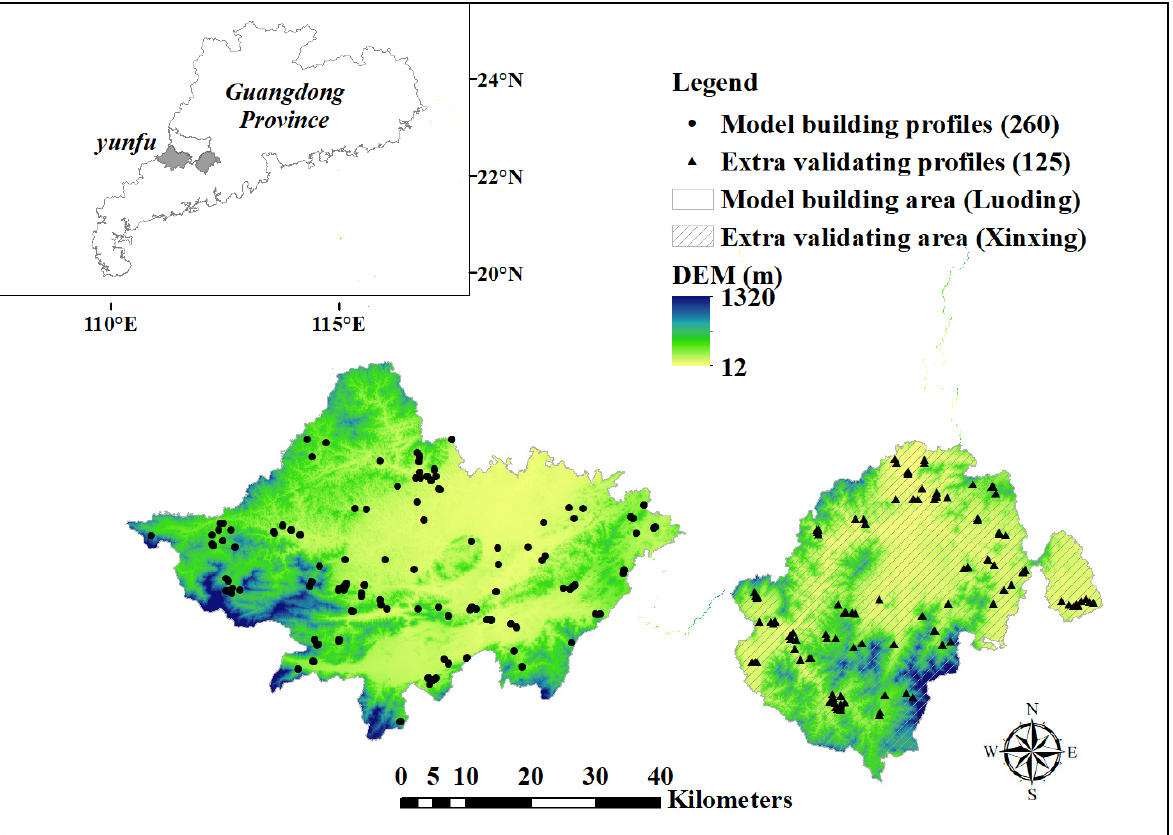
Figure 1. DEM and soil profile distribution in model building and extra validating areas.